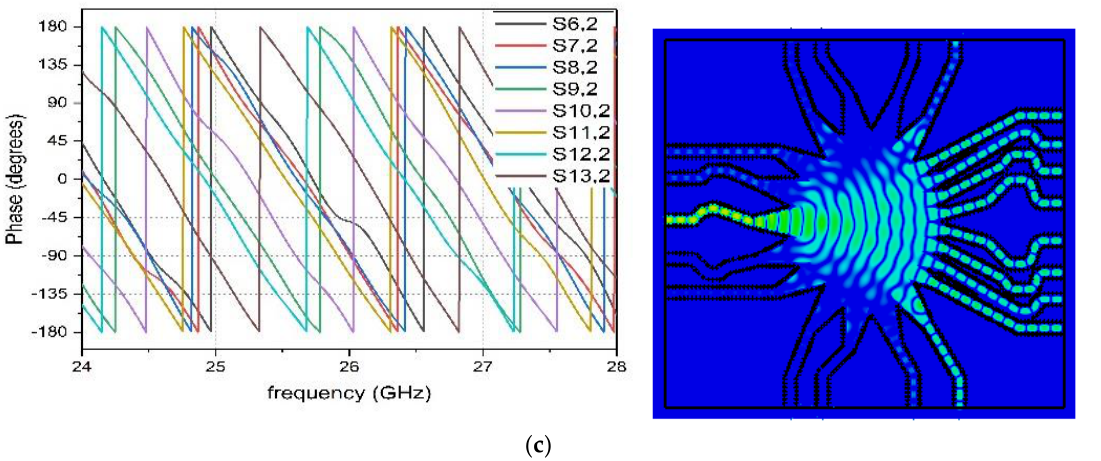
Figure 6. S-parameters of SICL-based RL at array ports showing linear progressive phase distributions along with electric field distributions when ( a ) beam port 1 is excited, ( b ) beam port 2 is excited, and ( c ) beam port 3 is excited at frequency of 26 GHz.